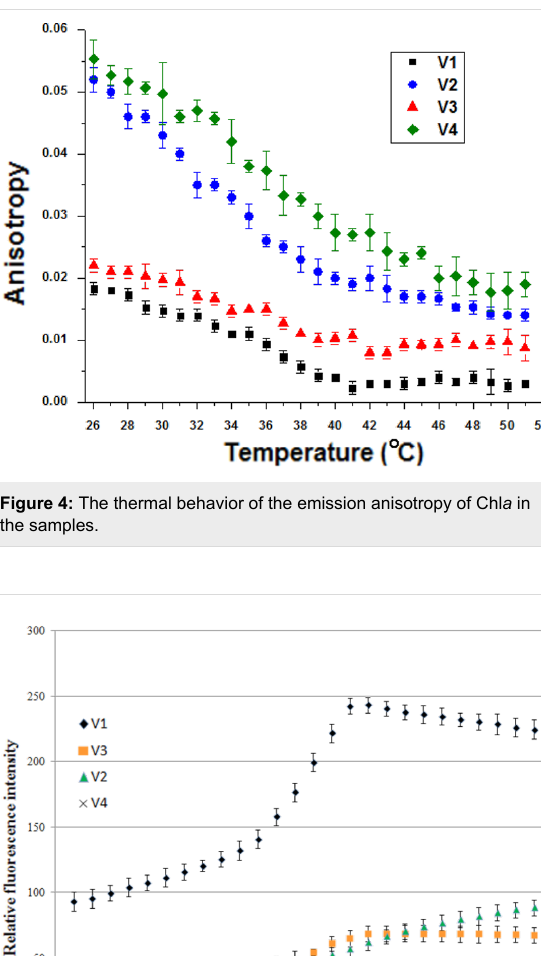
The spectral fingerprint of the Chl a sensor consists of specific absorption bands: in the red region (an intense peak at about 670 nm) and in the blue region (Soret band) of the electromag- netic spectrum.